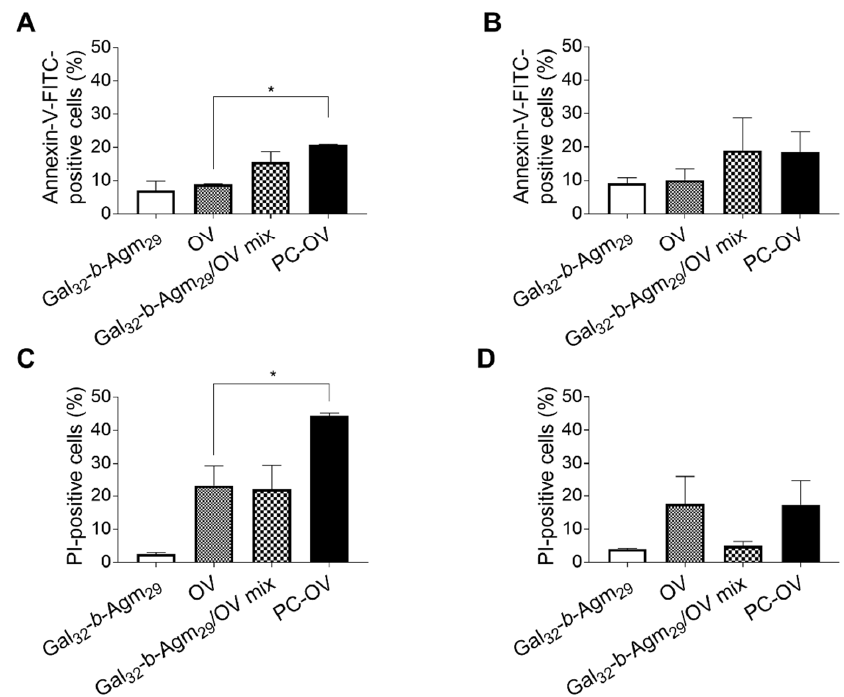
Figure 4. Induction of apoptotic and necrotic cell death. Early apoptotic ( A , B ) and late apoptotic/necrotic ( C , D ) cell death in HepG2 ( A , C ) and A549 ( B , D ) cells at 48 h post-treatment. FITC-labeled Annexin-V and PI were used to detect the early apoptotic cell and the necrotic or late apoptotic cells, respectively. Representative dot plots and histogram analyses are shown in Figures S16 and S17. Error bars, mean ± SEM; * p < 0.05.